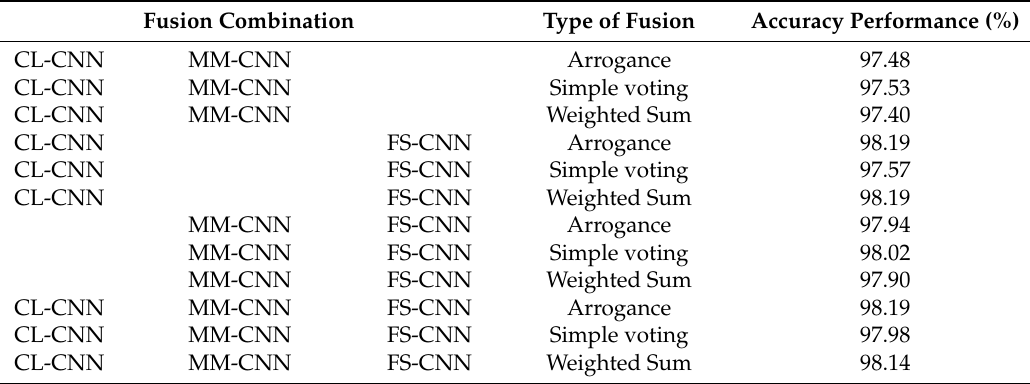
Table 7. Performance of fusing classifiers outputs from the first set of experiments.